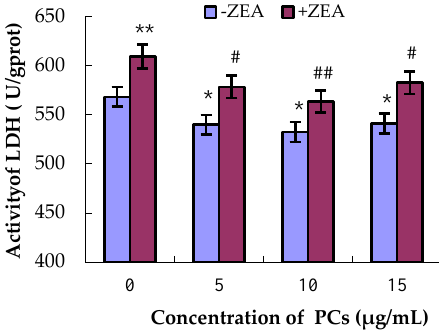
Figure 3. Effects of different concentration of proanthocyanidins (PCs) on the activities of lactate dehydrogenase (LDH) in MODE-K cells with or without 65 μmol/L zearalenone (ZEA). The activities of LDH increased when the cells were exposed to ZEA, while the activities of LDH decreased when the cells were treated with PCs. PCs could also decrease the increase in the activities of LDH when the cells were exposed to ZEA. * p < 0.05 and * * p < 0.01 vs. control group; # p < 0.05 and ## p < 0.01 vs. ZEA-treated group.